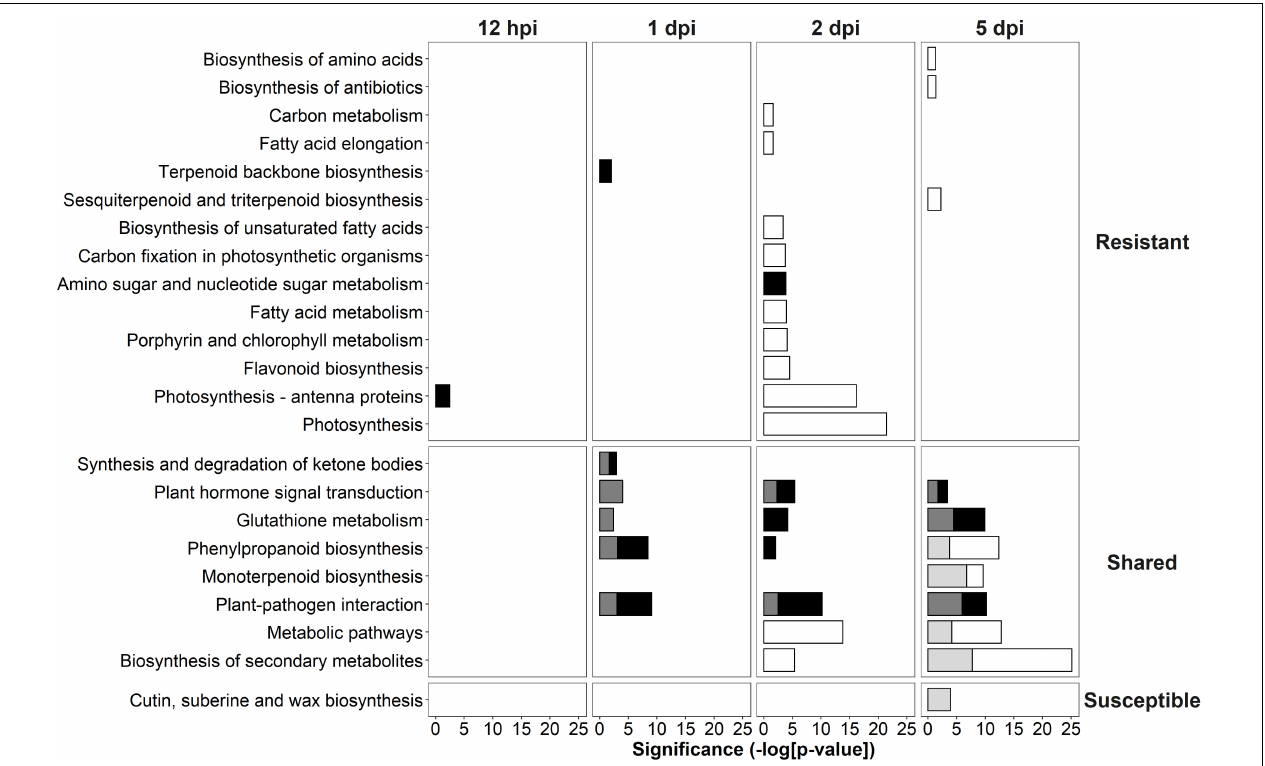
FIGURE 4 | Kyoto Encyclopedia of Genes and Genomes (KEGG) analysis of significantly differentially expressed genes (DEGs) in the R- and S-interactions over time showing the significance of each over-represented term. White bars indicate down-regulated resistant, black bars indicate up-regulated resistant, light gray bars indicate down-regulated susceptible and dark gray bars indicate up-regulated susceptible. KEGG terms were separated into those unique to the R-interaction, shared in both the R- and S-interactions and unique to the